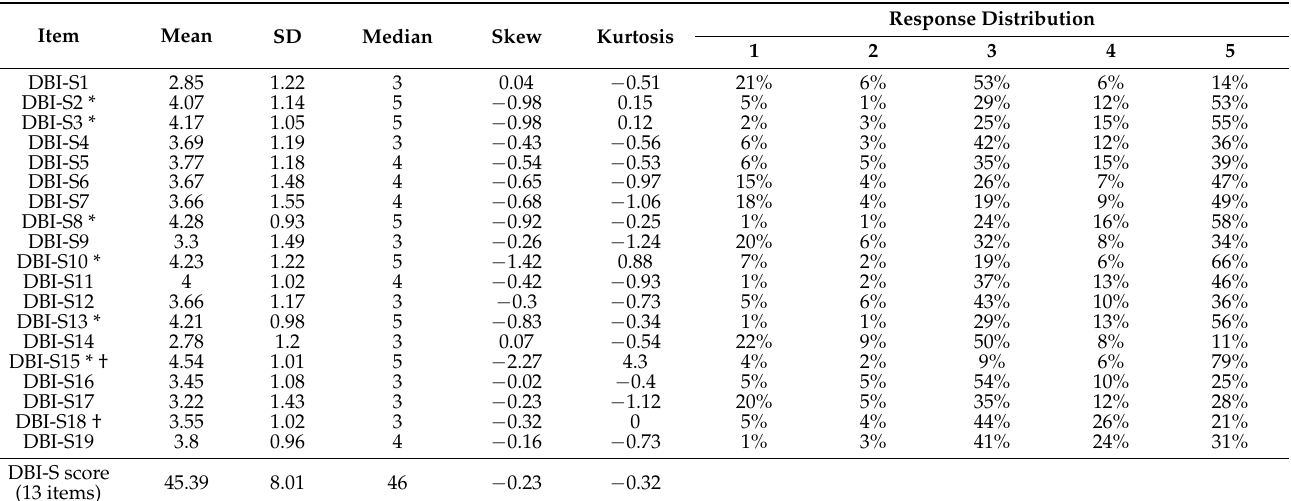
Table 2. Descriptive statistics of the DBI-S